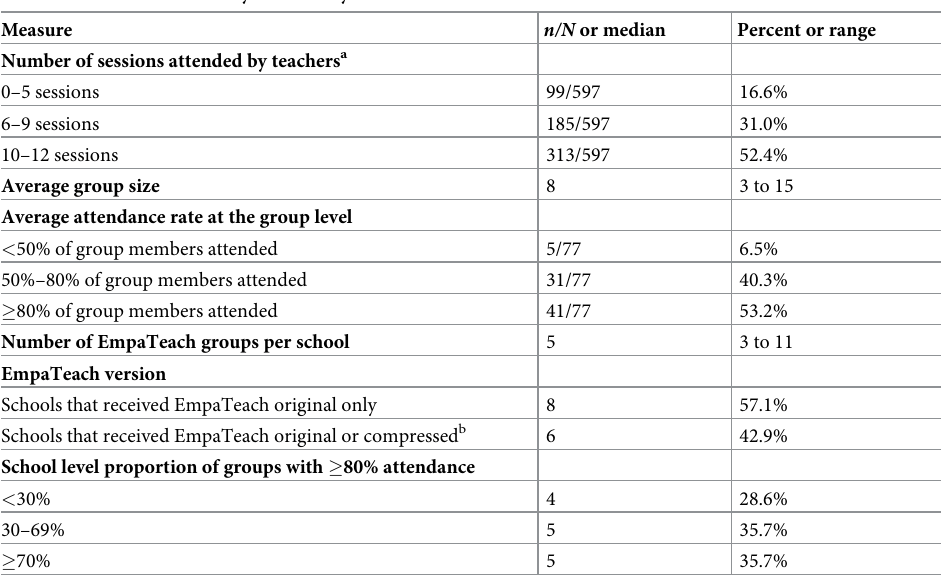
Table 2. Intervention delivery and fidelity. AU : ThereweretwofootnotesinthelegendforTable 2 ð originallymarkedbyacaratandanasterisk ; nowmarkedaandb Þ thatdidnothaveamatchingsymbolinthetableitself : IhaveaddedthefootnotesymbolsinthetablewhereIthinktheyaremeanttoapply ; butifthesymbolsarenotcorrectlyplaced ; pleaseeditasnecessary